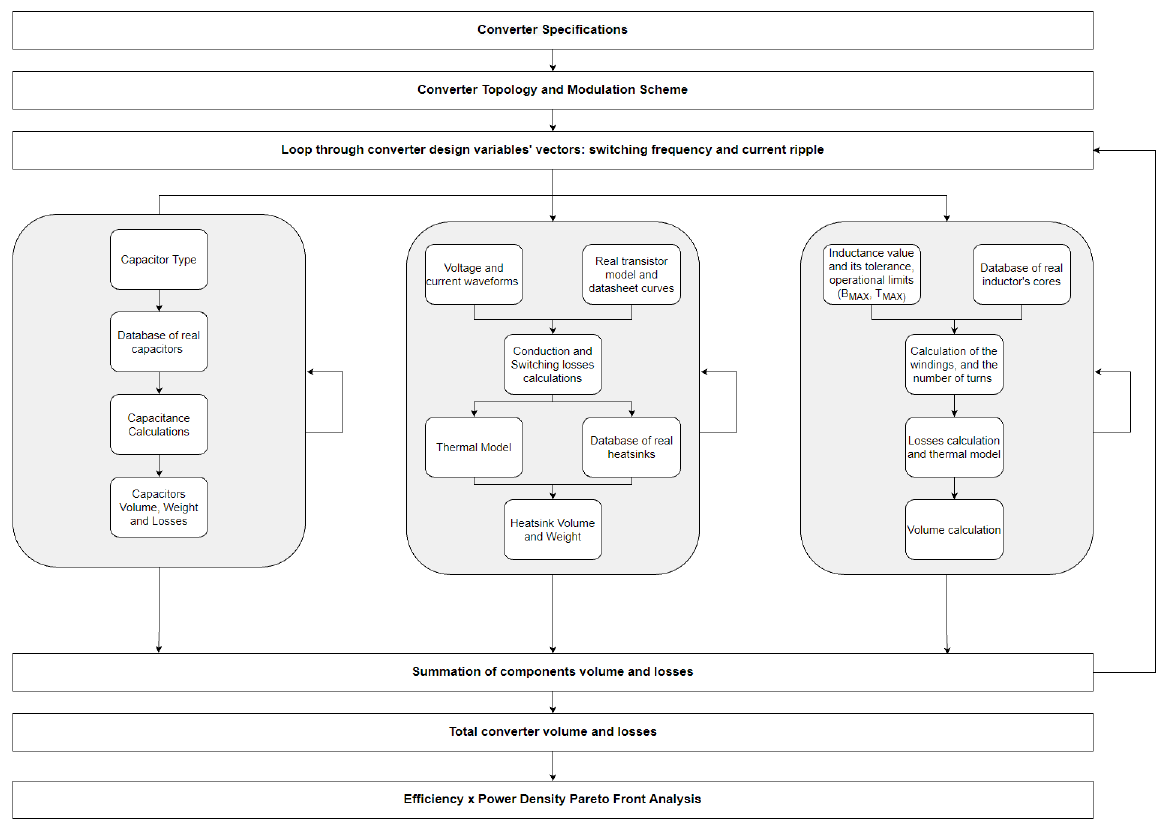
Figure 1. Flowchart of the local (component level) and global (system level) optimization of a power electronics converter considering the selection and design of the main functional elements of the power circuit. As explained in [7], by neglecting parasitic effects (wiring inductances, electromagnetic and thermal coupling of components, etc.) component designs are largely decoupled and/or individ- ual local optimizations can be carried out; only the component values, the switching frequency f sw , and the ripple current are then determined by an outer global optimization